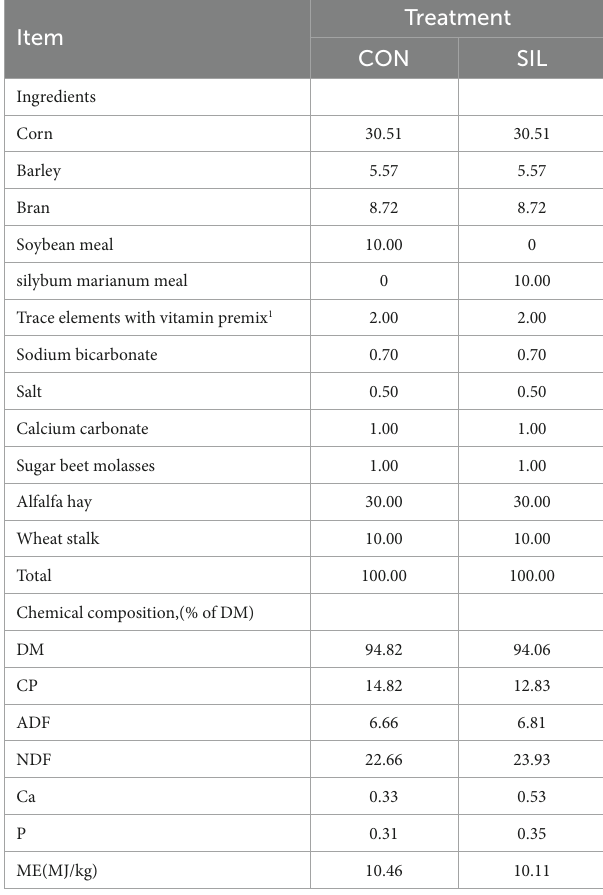
TABLE 1 Ingredient and chemical composition (% DM) of the experimental